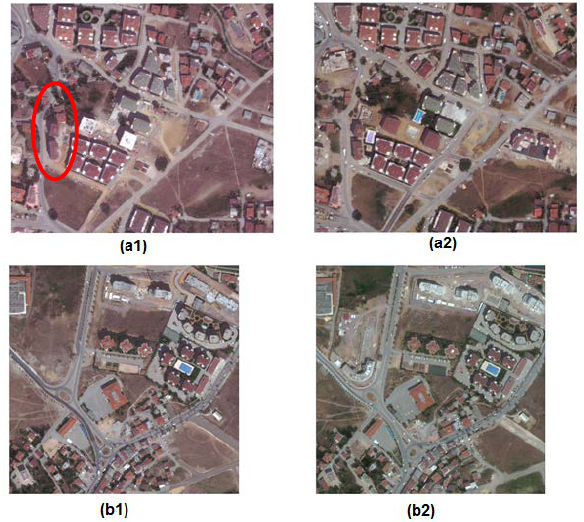
Figure 8. Study sites: (a1, b1) are the pre-event images. (a2, b2) are the after-event change images.